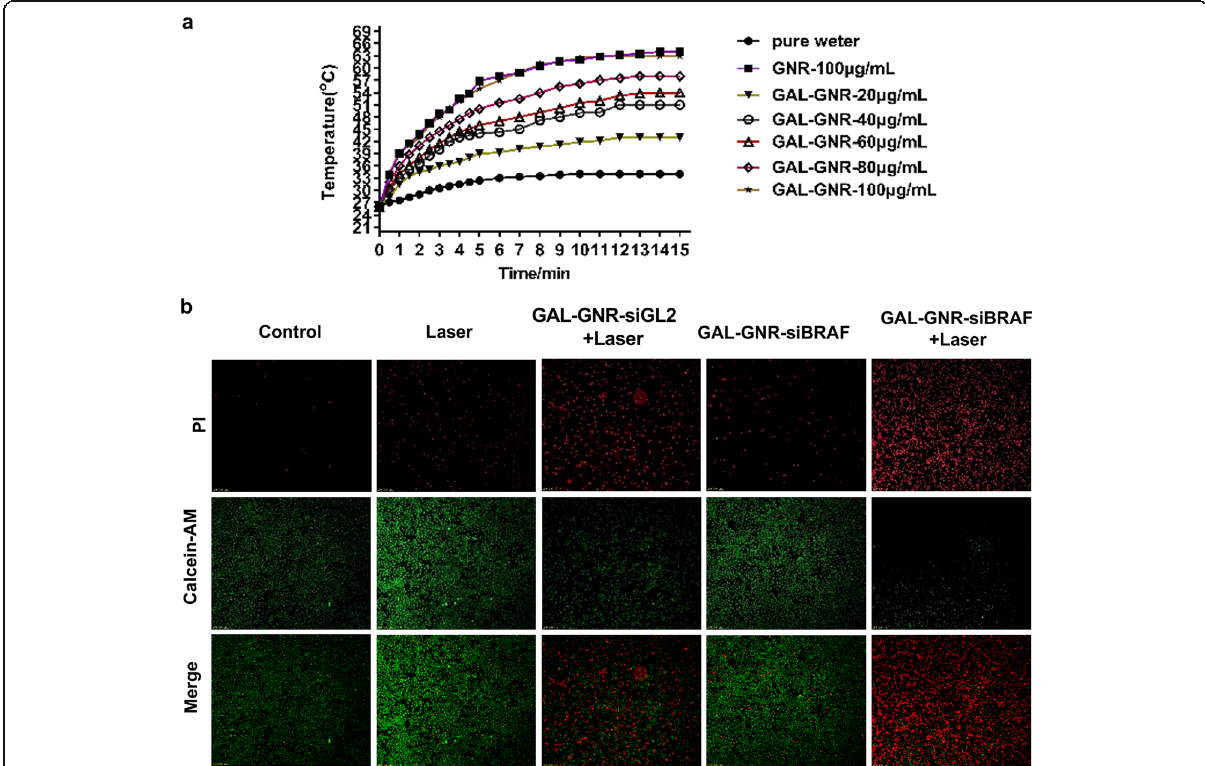
Fig. 6 Photothermal effect induced by GAL-GNR and combination treatment of photothermal effect and gene silencing on liver cancer cells. a 803 nm near-infrared laser source (2 W/cm 2 ) was used to irradiate the solution of GNR, GAL-GNR, or distilled water (blank control) for 15 min. The temperature was detected by infrared thermometer at different time point. b Hepa1-6 cells were treated with PBS, laser, GAL-GNR-siBRAF, GAL- GNR-siGL2 + Laser, or GAL-GNR-siBRAF + Laser, respectively. Green fluorescence of calcein AM (live cells) and red fluorescence of PI (dead cells) were observed under fluorescence